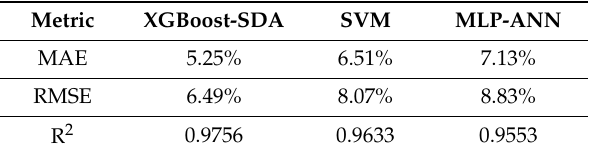
Table 8. Performance comparison of XGBoost-SDA, SVM, and MLP-ANN.